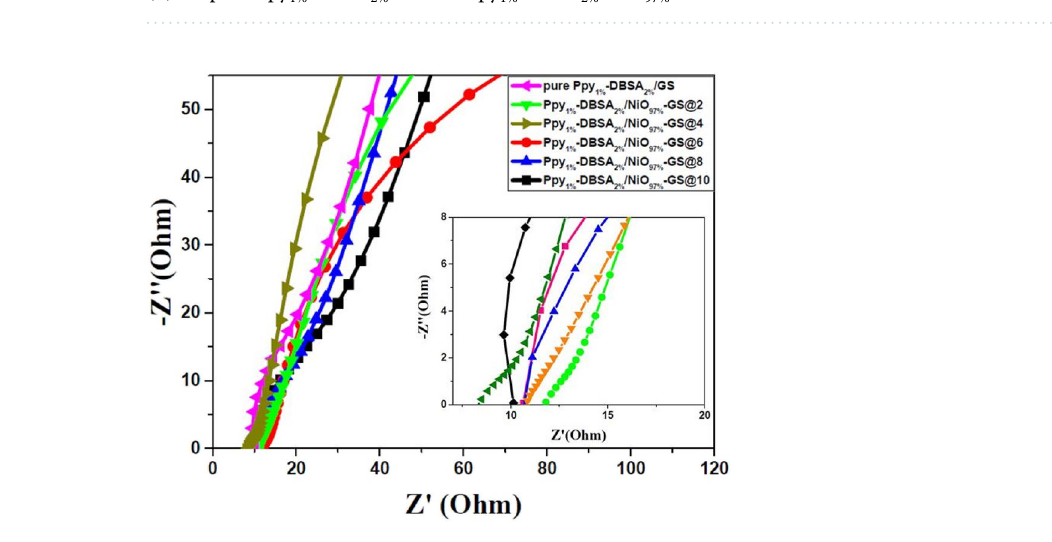
Figure 7. Specific capacitance at different scan rates ( a ) and specific capacitance at different current densities ( b ) for pure Ppy 1% -DBSA 2% /GS and Ppy 1% -DBSA 2% /NiO 97% -GS@4.